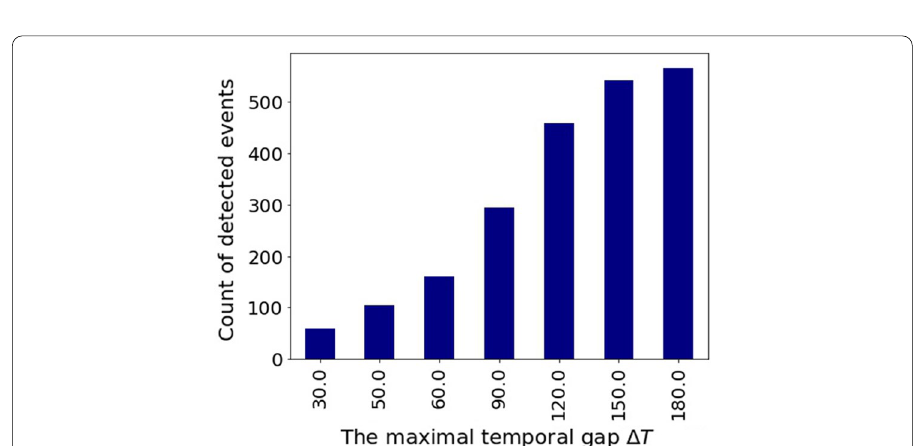
Fig. 6 The number of detected events using different values for (cid:31) T (in minutes)